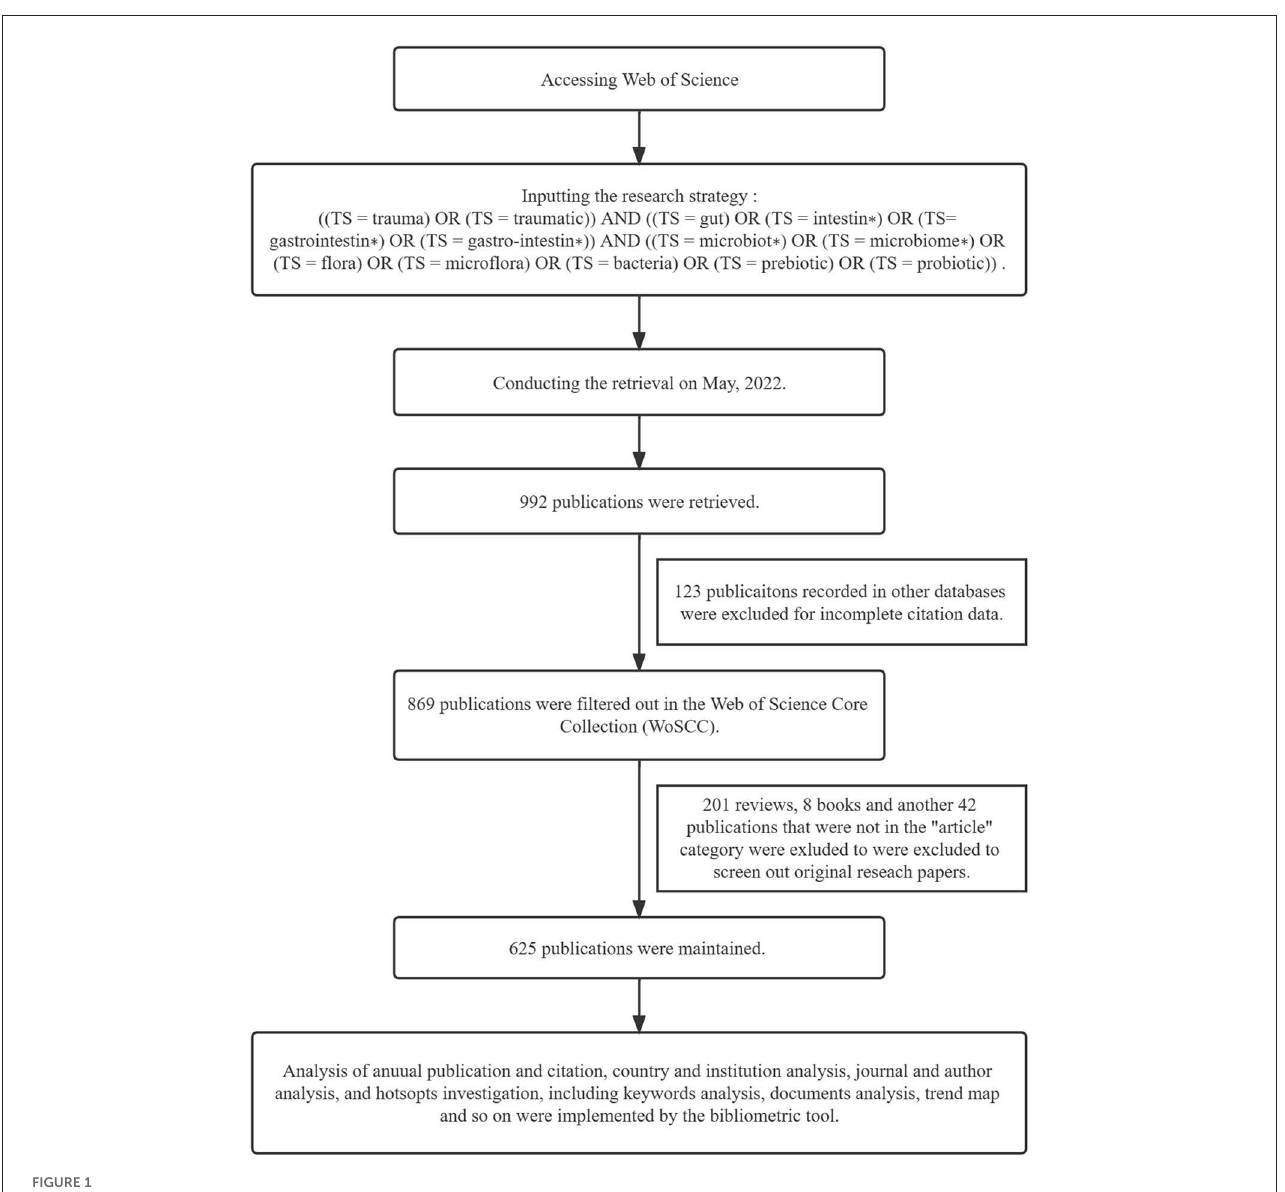
FIGURE1 The retrieval flow